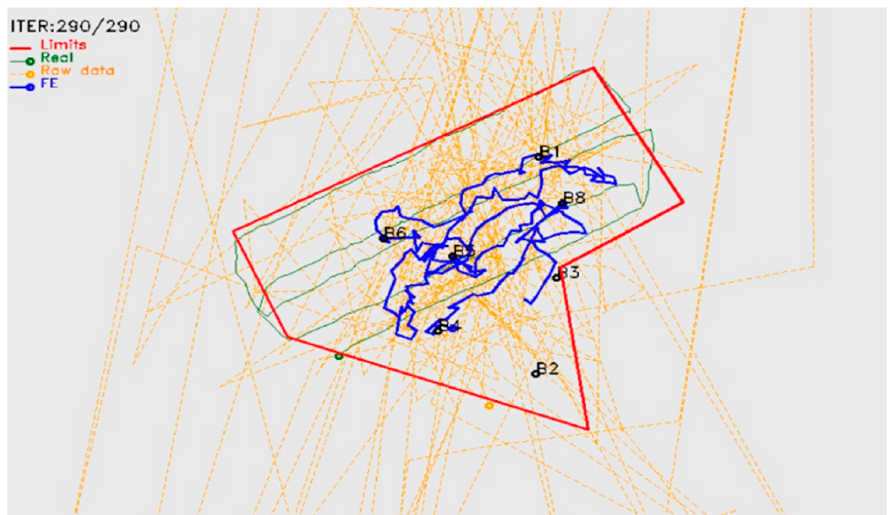
Figure 9. Post-sheepIT localization results.